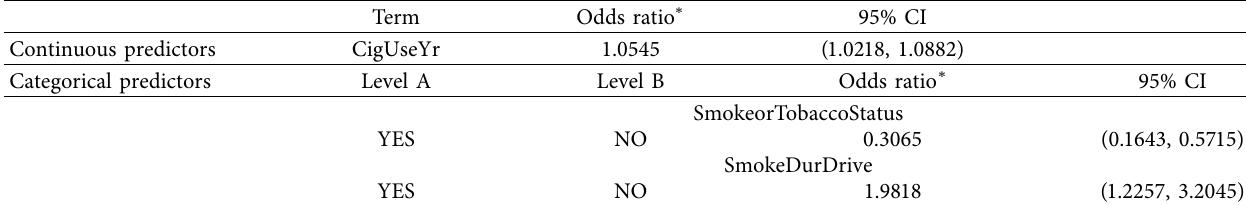
Table 10: Odds ratios of the second binary logistic regression model.